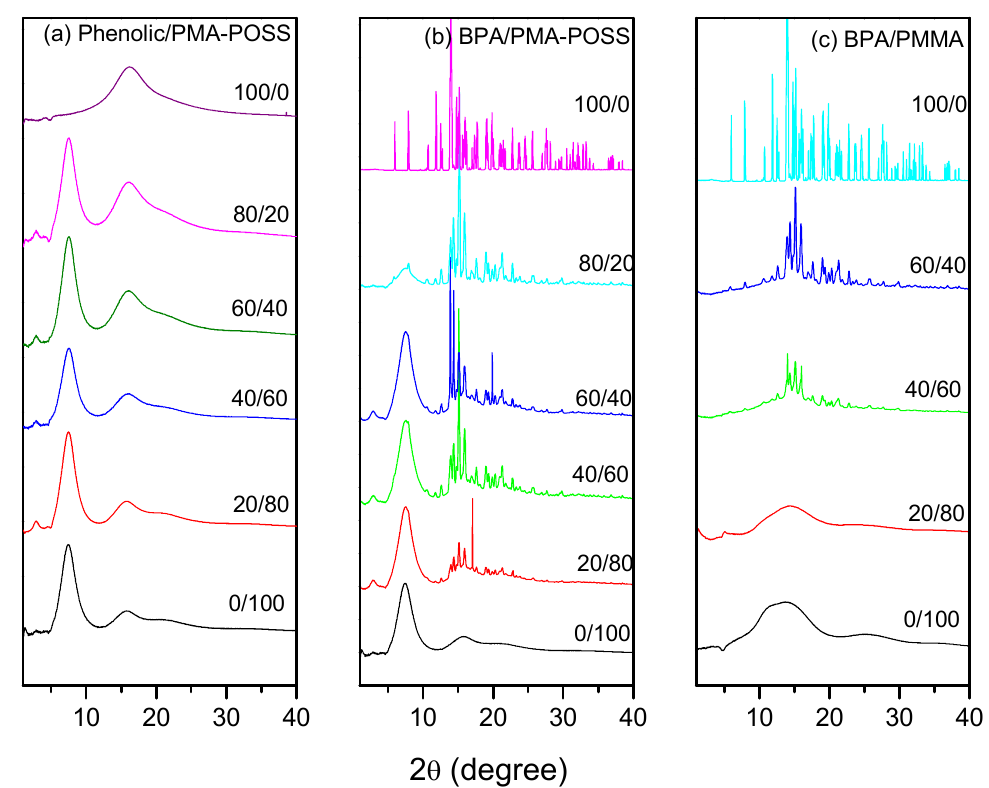
( c ) BPA/PMMA blends, recorded at room